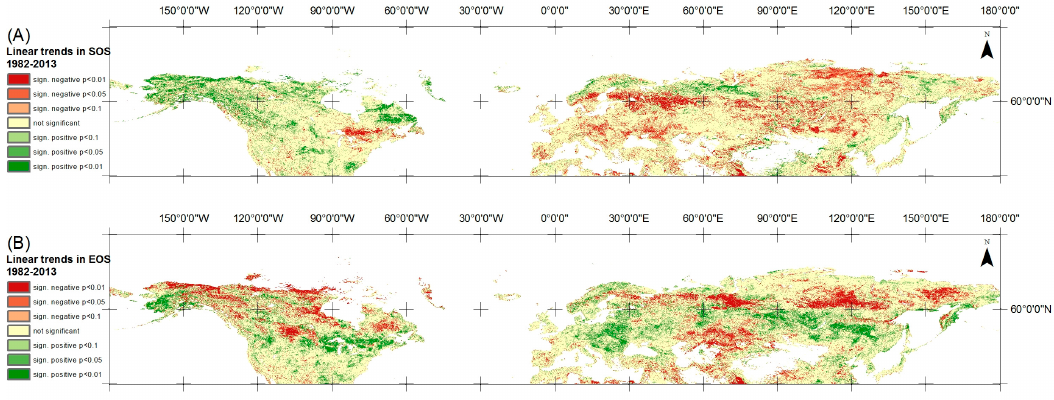
Figure 2. Cont. Figure 2.